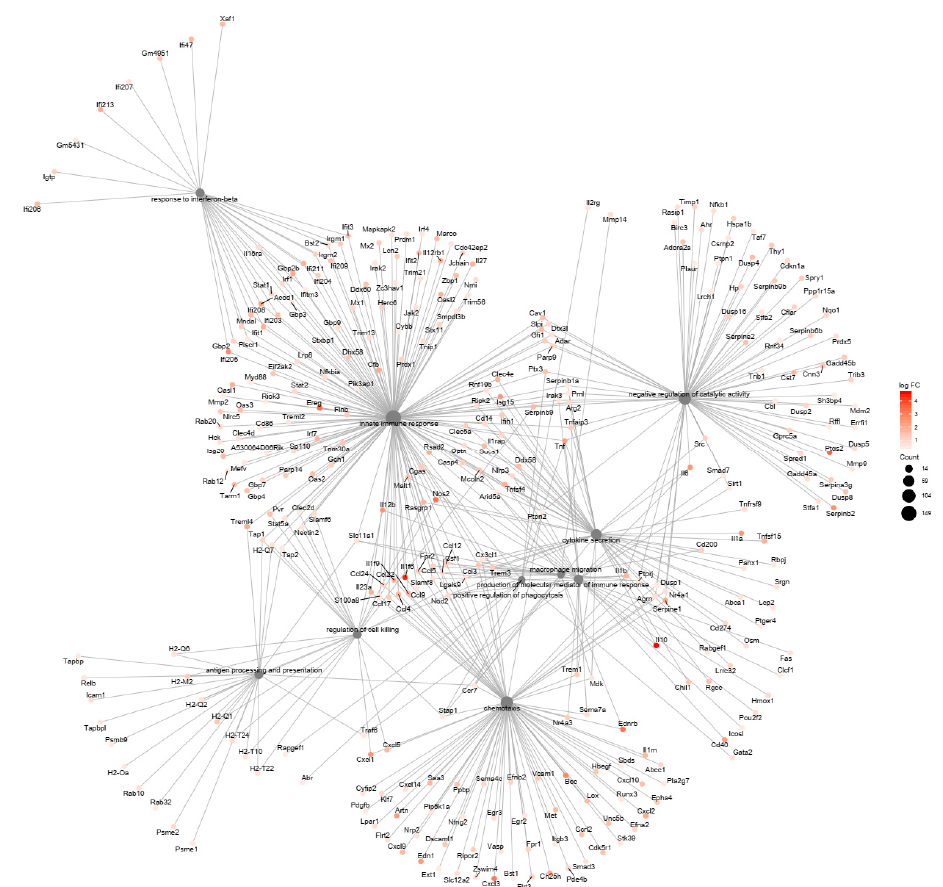
Figure 4. Functional interaction networks related to biological process Gene Ontology terms enriched by genes upregulated in response to P. brasiliensis infection in BMDCs from the susceptible mouse strain, B10.A. ClusterProfiler was used to generate the functional interaction networks formed by upregulated genes related to the GO Biological Process terms. Dot size represents the number of genes in each GO term.